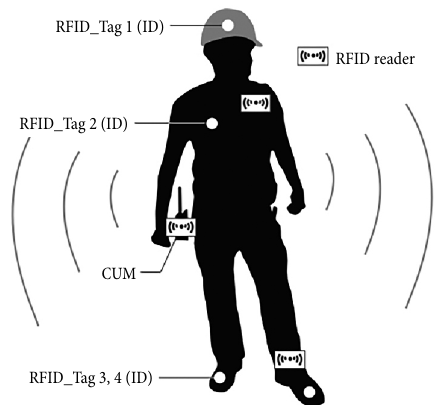
Fig. 3. Self-checking system of the worker’s PPE proper usage – adapted from Barro-Torres et al.